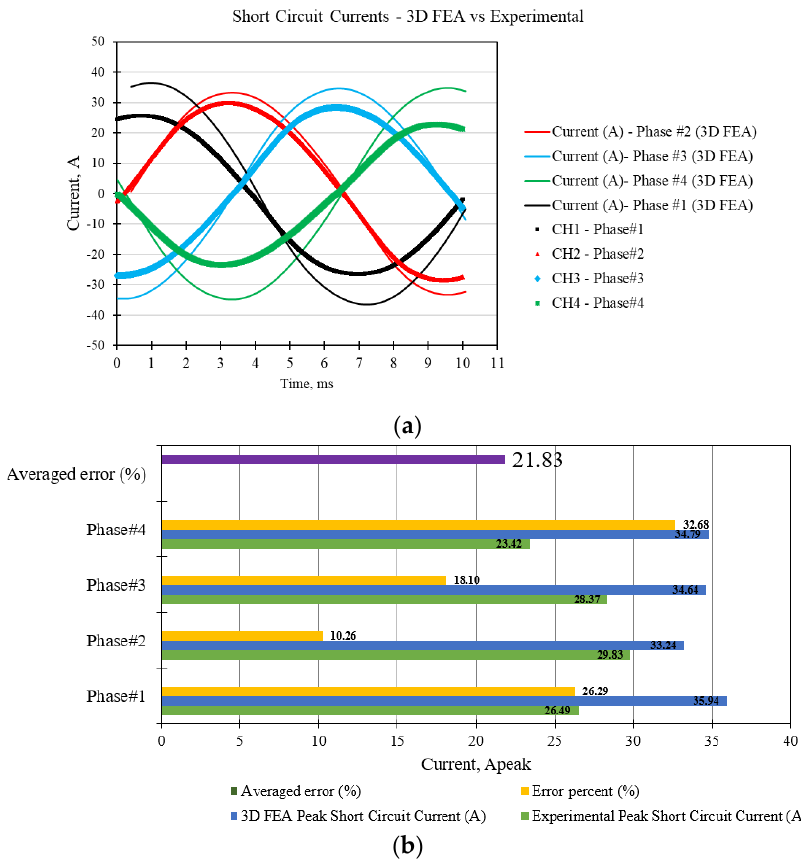
Figure 13. Short circuit test results: ( a ) 3D FEA vs. experimental, ( b ) SC error comparison.